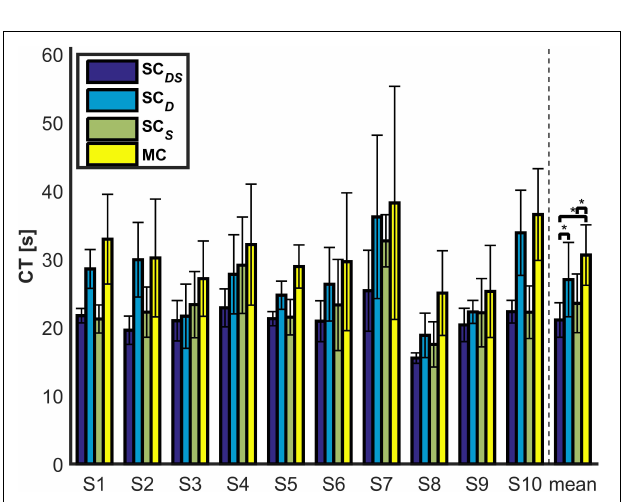
FIGURE 11 | The CTs for each subject and across subjects (the across-subjects performance difference with statistical significance is marked by “*”, p <